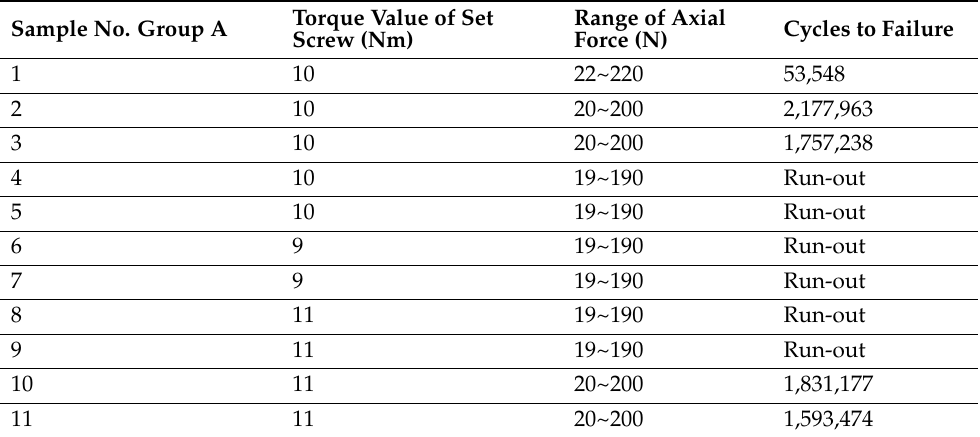
Table 3. Results of the dynamic compression bending test.